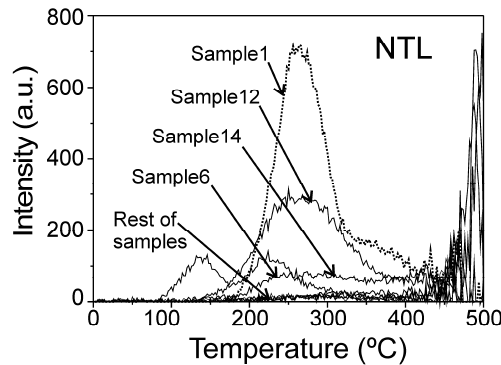
Fig. 3 – Thermoluminescence glow curves of slag materials; note the low emission signals in all